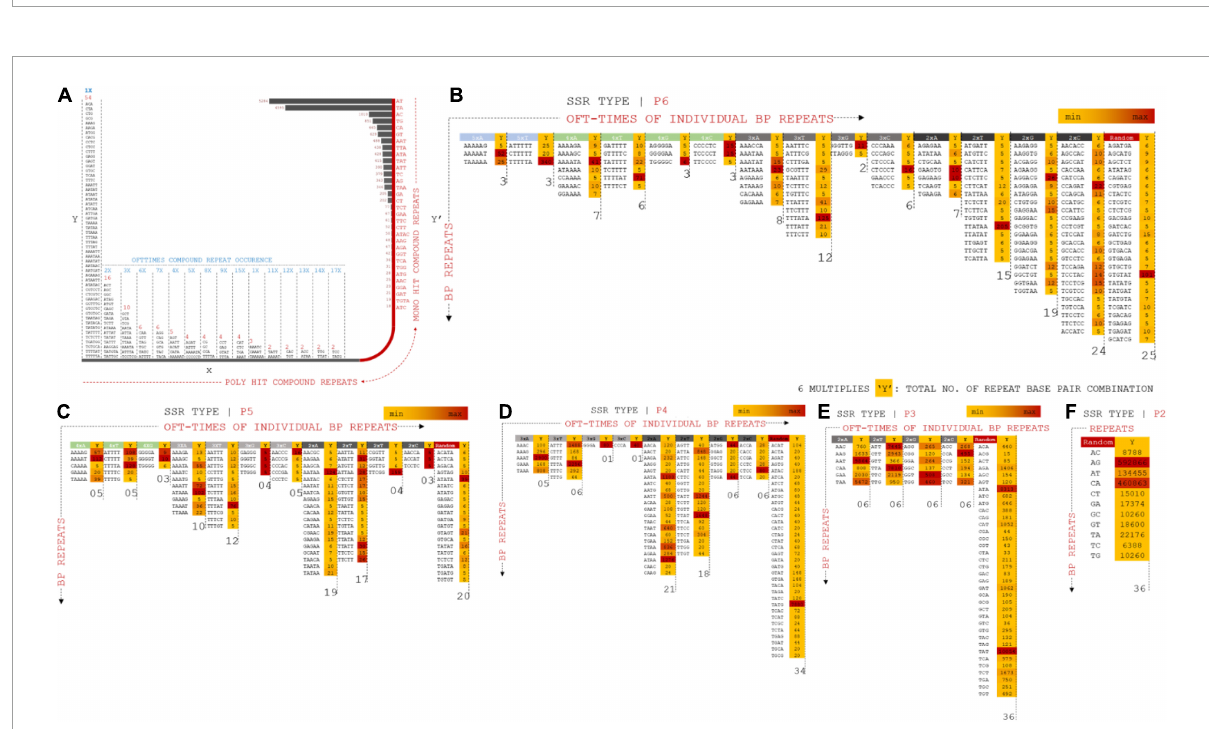
FIGURE4 (A) Compound repeats from assembled reads were plotted from the distribution of offtimes of repeat occurrence and number of hit (mono and poly hits). X-Y coordinate prevails the distribution of compound repeats in multiple combinations whereas X–Y’ projects mono repeats with multiple form bp combinations. (B) P6 SSR operons mapped for distributed combinations for 5xX (A, T, G, C), 4xX, 3xX, 2xX, and random specificity of repeats. Operons are projected on positioning oft-time count, Y multiples of each marker types. (C) P5 SSR operons mapped for distributed combinations for 4xX (A, T, G, C), 3xX, 2xX and random specificity of repeats. (D) P4 SSR operons mapped for distributed combinations for 3xX (A, T, G, C), 2xX and random specificity of repeats. (E) P3 SSR operons mapped for distributed combinations for 2xX (A, T, G, C) and random specificity of repeats. (F) P2 SSR operons mapped for distributed combinations for random specificity of